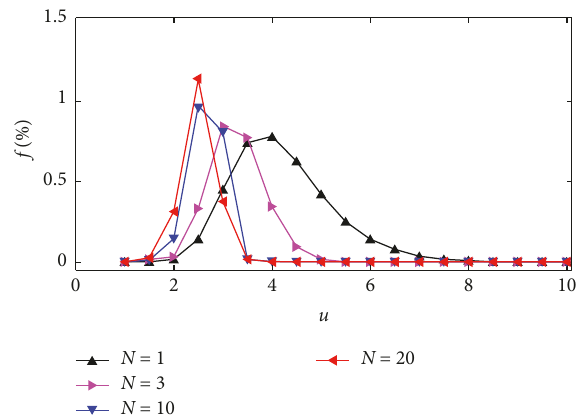
Figure 5: The collision probability f for different theoretical times of vehicles in consideration of the group